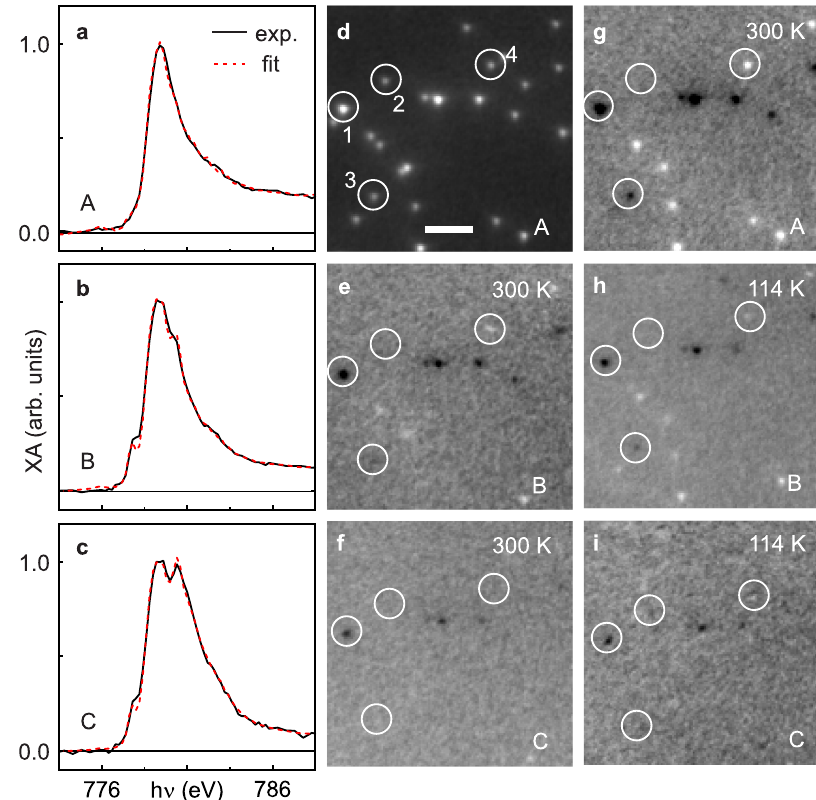
Fig. 5 | Temperature dependent magnetic state of pure and oxidised nano- particles. a – c X-ray absorption (XA)spectraof Conanoparticlesatstates A,B,and C (black lines; dashed red lines are fi ts to the data). d , g X-ray photoemission electron microscopy (XPEEM) Co elemental map and x-ray magnetic circular dichroism(XMCD)contrastmapofthenanoparticlesat300KinstateA. e , h XMCD contrast maps of the nanoparticles upon oxidation to state B at 300K and at114K